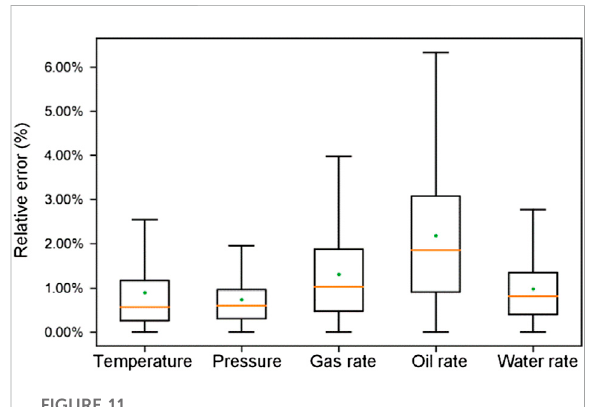
FIGURE 11 The distribution of relative error for all test cases and nodes.